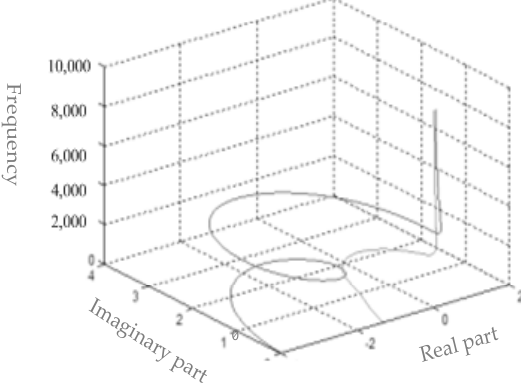
Figure 5. The 3D map of complex domain with frequency feature.